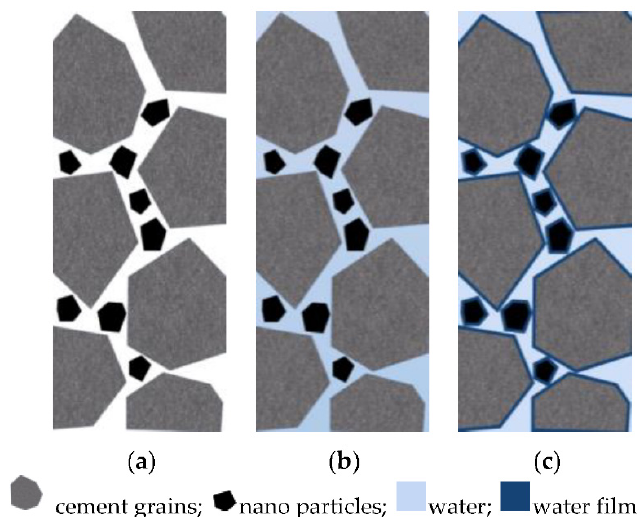
Figure 5. Formation and changes of WFT [11,65,66]. ( a ) The close packing of cementitious particles; ( b ) The mixed water fills the voids between particles; ( c ) the excess water forms a water film on the particles’ surface.